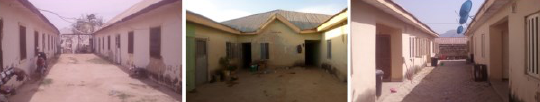
Figure 2. Houses were built within fence walls and around the courtyard allowing windows to be